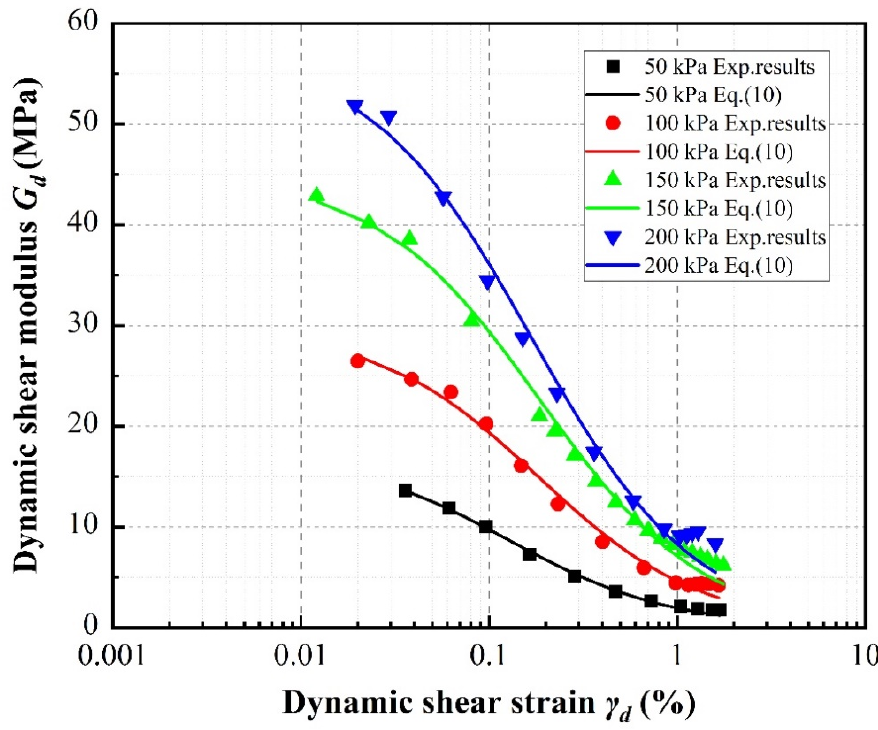
Figure 11. Effect of confining pressure on dynamic shear moduli of SRP2 sand–rubber mixtures with 20% rubber contents.